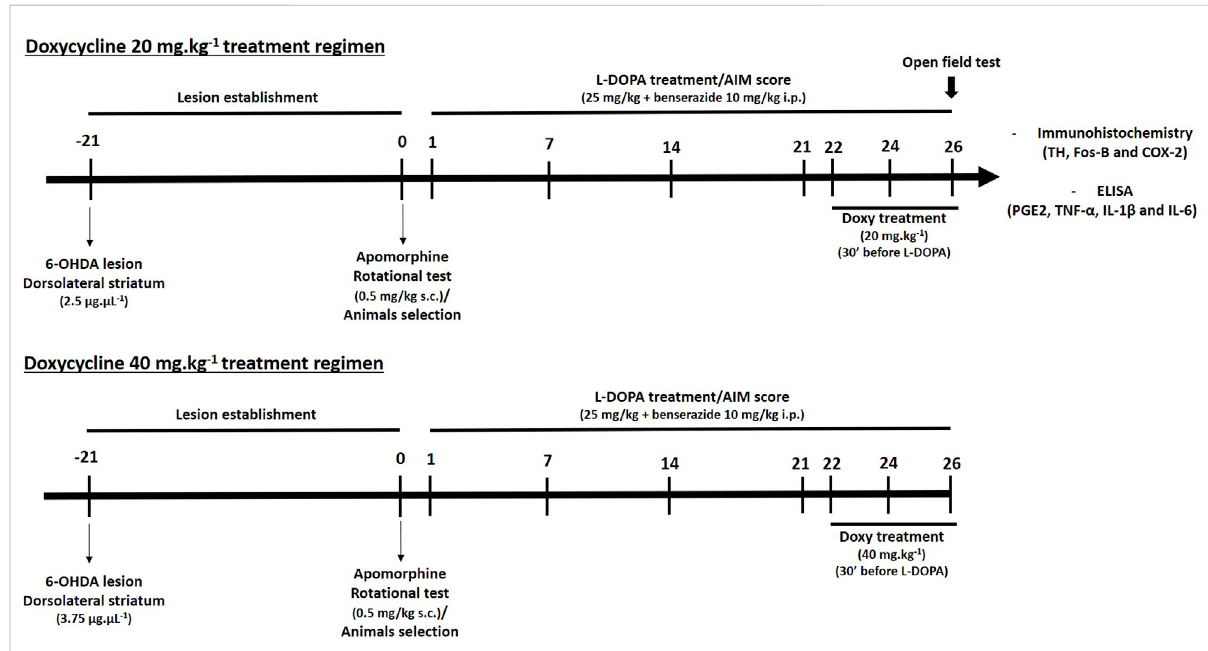
FIGURE 1 SchematicdrawingofDoxypharmacologicaltreatmentsinhemiparkinsonianmicewithestablishedLID.Eighty- fi vemicewereselectedafter6- OHDA stereotaxic surgery (solutions of 2.5 or 3.75 µg µl − 1 of 6-OHDA were used for Doxy 20 mg kg − 1 or 40 mg kg − 1 treatment groups, respectively) employing the apomorphine rotational test (0.5 mg.kg-1 s. c.). These mice were then treated chronically with L -DOPA for 21 days (25 mg kg − 1 + benserazide10 mg kg − 1 i.p.once/day)andscoredforAIMs.OnceAIMshadbeenevaluated,hemiparkinsoniandyskineticmiceweredividedinto Veh- and Doxy (20 and 40 mg.kg − 1 s. c.)-treated groups with equivalent AIMs scores. Then, a sub-chronic treatment with Doxy + L-DOPA or Veh + L-DOPA was administered for the next 5 days. During this period, mice were scored for AIMs on days 1, 3, and